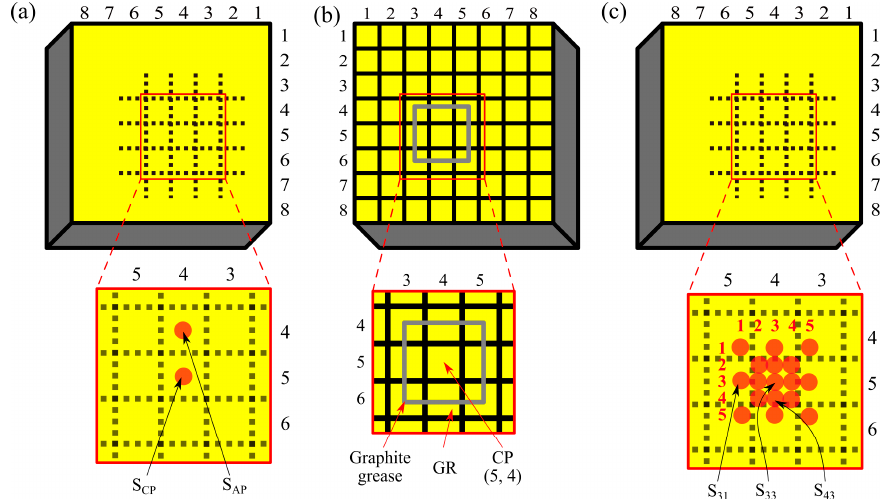
Figure 3. Detector configuration for the L ‐ TCT measurements: ( a ) Cathode view with illuminated spots used in the first experiment; ( b ) anode view with central pixel (CP) and guard ring (GR) configuration; ( c ) cathode view with illuminated spots used in other experiments. Table 1. Position of illuminated spots. All measured distances have equal systematic fault ± 0.25 mm. Illuminated